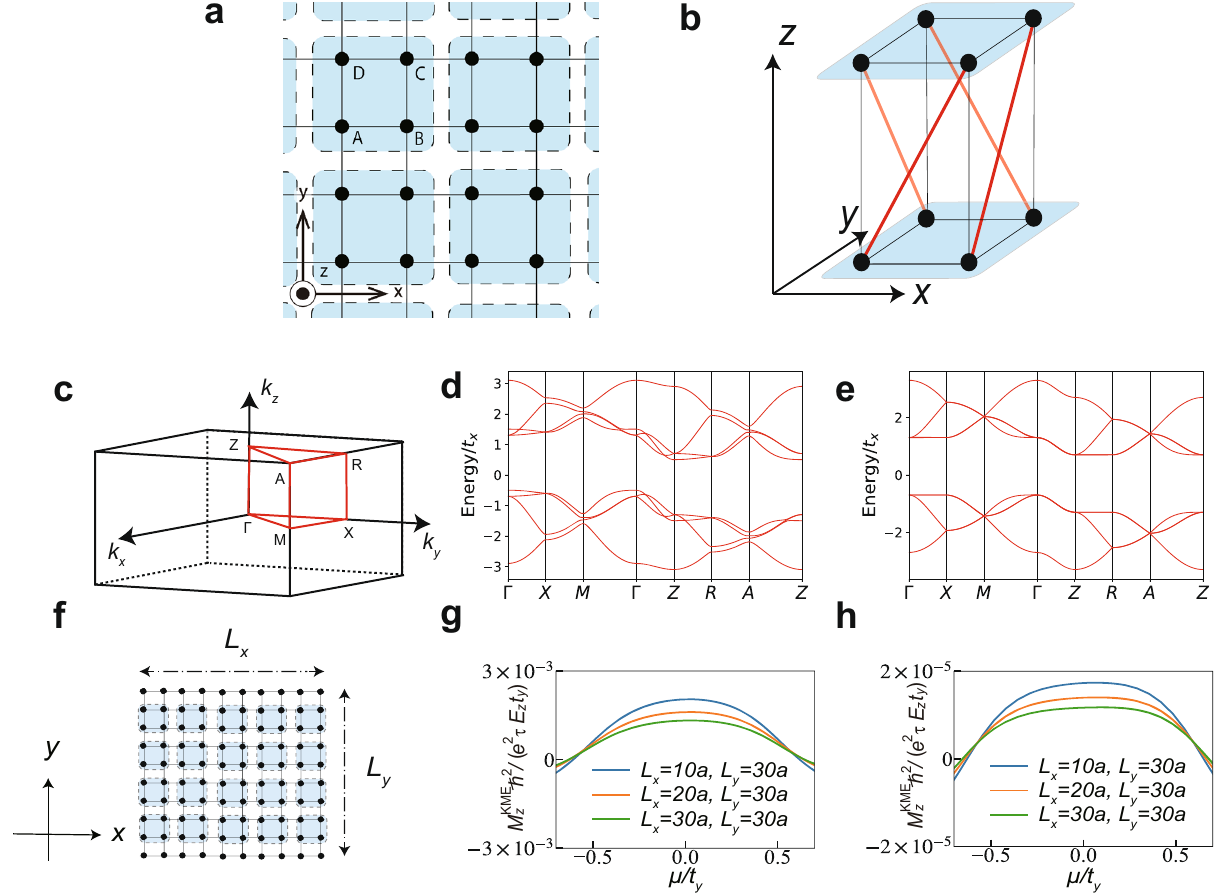
Fig. 1 The model of a Chern insulator with a chiral structure and model calculation of the kinetic magnetoelectric effect (KME). a Individual layer of the model forming a square lattice. The blue regions surrounded by the broken line are the unit cells consisting of four sublattices. b Schematic picture of the chiral hopping (red) between the two neighboring layers. These hoppings form a structure similar to right-handed solenoids. c Brillouin zone of our model with high-symmetry points. d , e Energy bands for the Hamiltonian H with parameters ( d ) t x = t y = m = b x = b y , t 3 = 0.1 t y and t 4 = 0.15 t y and ( e ) t x = t y = m = b x = b y , t 3 = 0.001 t y and t 4 = 0.15 t y . The symbols such as Γ and X represent high-symmetry points in the wavevector space. f A one- dimensional model with periodic boundary conditions in z -direction. It has a rectangle shape of a size L x × L y within the xy plane. The dots are the sites, and th blue squares denote the unit cells, as speci fi ed in a . In order to see the boundary effect on KME, the outermost layers on the xz surface have no chiral hoppings and those on the yz surface have chiral hoppings. g , h KME calculated with parameters ( g ) t x = t y = m = b x = b y , t 3 = 0.1 t y and t 4 = 0.15 t y and ( h ) t x = b x = t y , t y = b y = m , t 4 = 0.15 t y , and t 3 = 0.001 t y . The blue, orange, and green curves represent the data for L x = 10 a , L x = 20 a , and L x = 30 a , respectively, while L y is fi xed as L y = 30 a